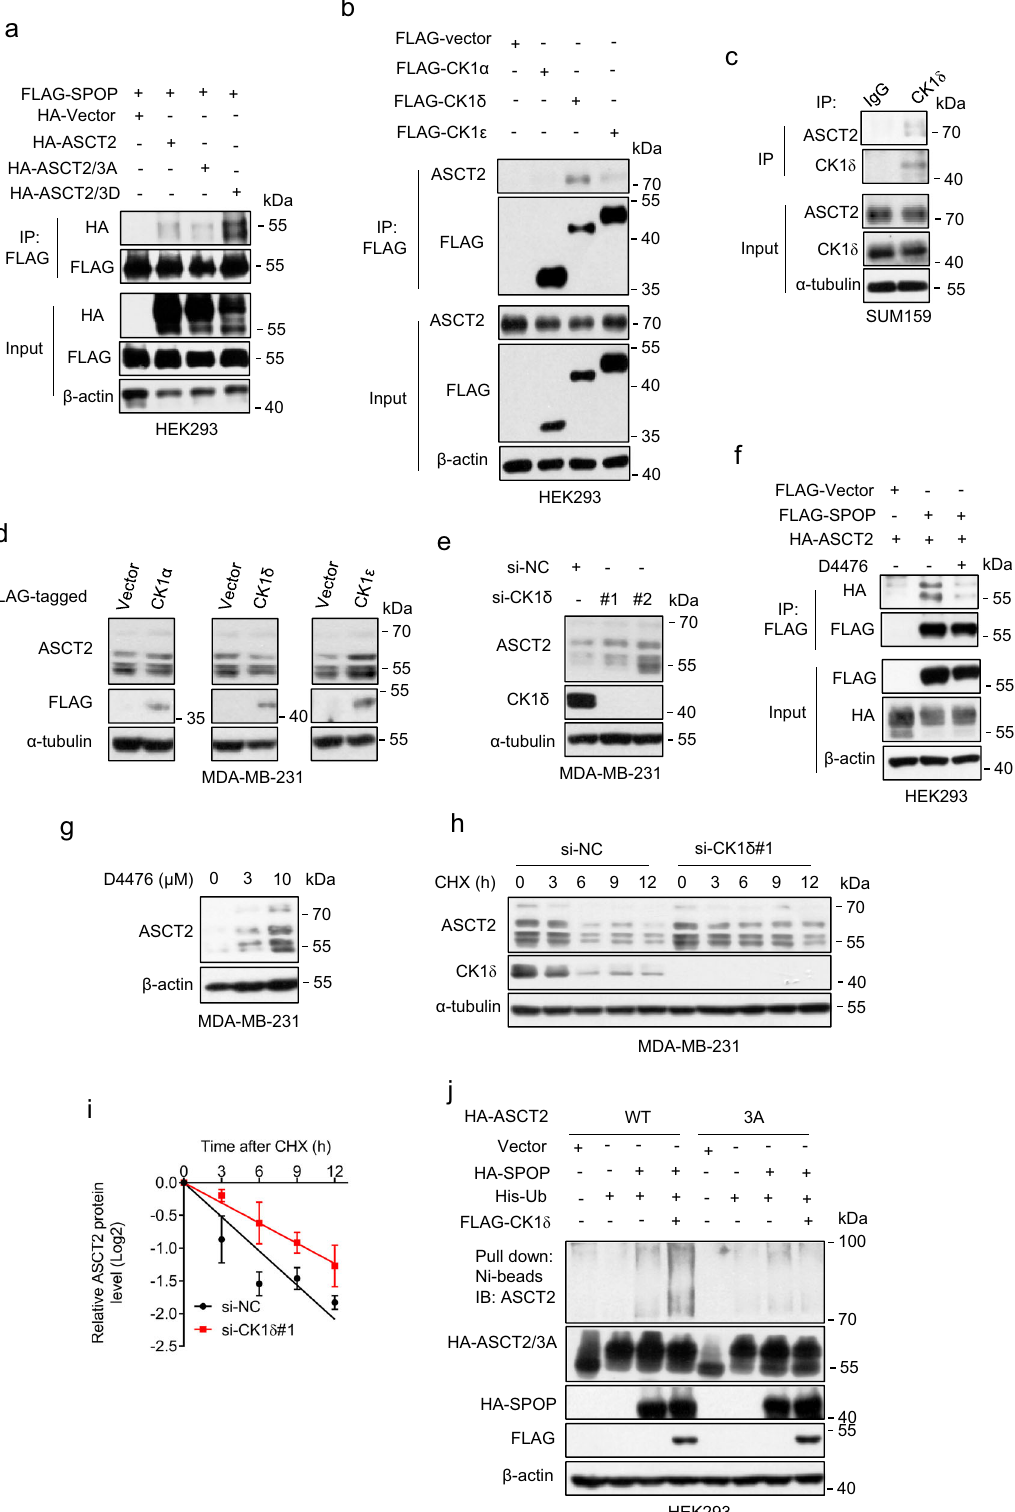
by simultaneous ASCT2 knockdown (Fig. 6b, c, Supplementary Fig. 7a, b). Consistently, compared with wild-type ASCT2, ectopic expression of ASCT2-3A, a SPOP-resistant mutant (Supplemen- tary Fig. 7c), enhanced cellular glutamine uptake and glutamate production (Fig. 6d, e, Supplementary Fig. 7d, e). Thus, the pro- motion of glutamine metabolism by